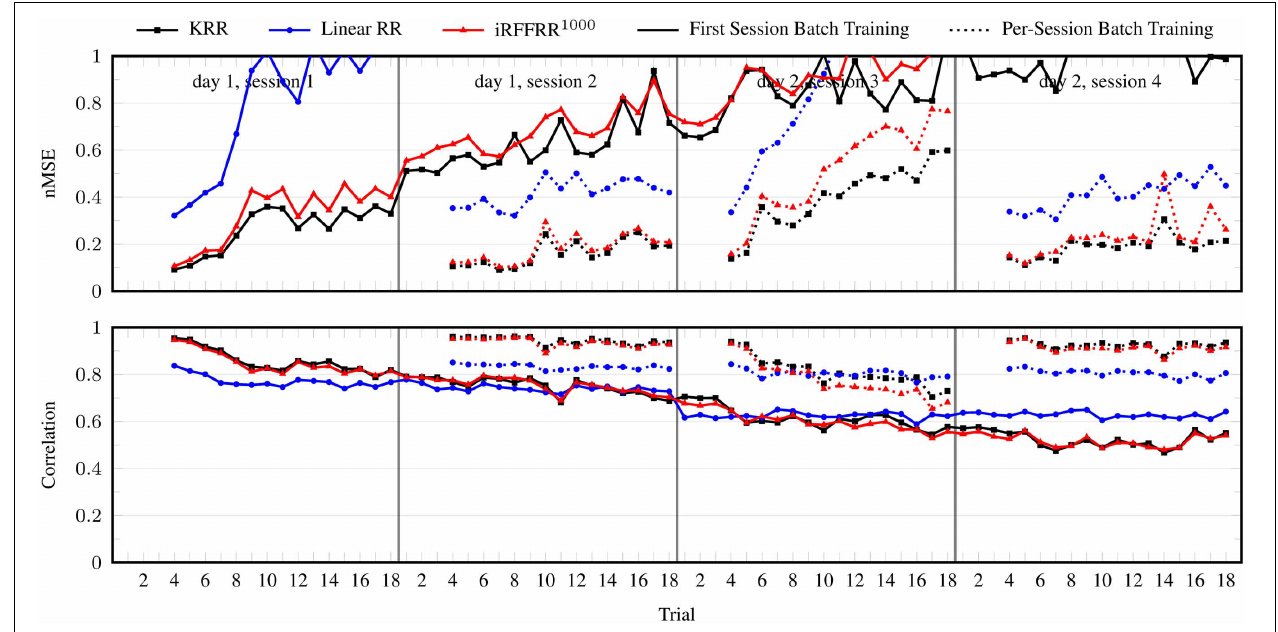
FIGURE 3 | nMSE and correlation coefficient per trial, in the batch setting: when training on the first three trials of the first session, and on the first three trials per session . Results for the linear RR and KRR